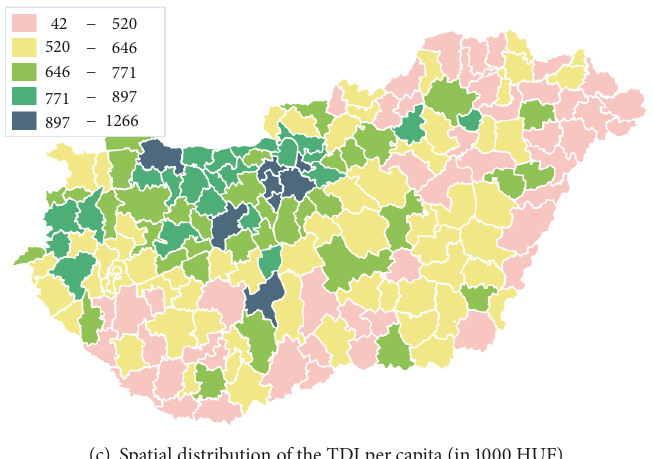
Figure 10: Communities formed by the Louvain method and gravitational null models reflect the attractiveness of Budapest as only less developed closed regions were not assigned to the module of the